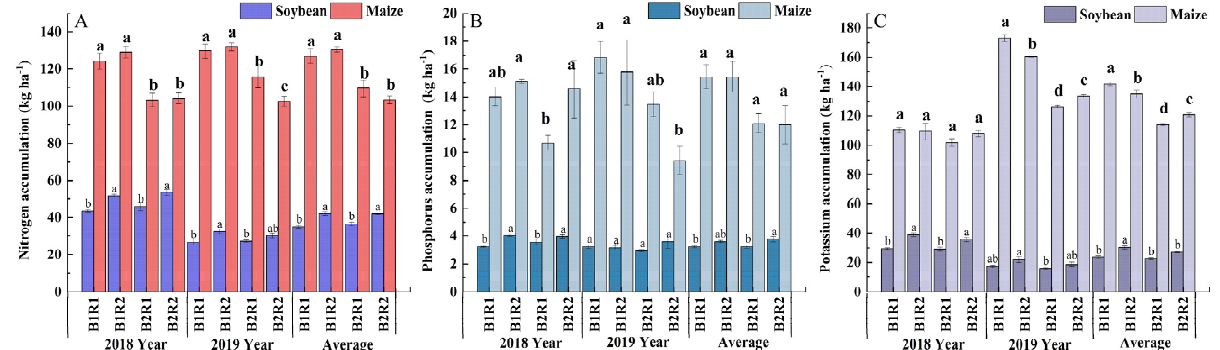
Figure 3. Nutrient accumulation of maize and soybean in sole and intercropping systems in the 2 yr. ( A – C ) represent the N, P, and K accumulation among different intercropping treatments, respectively. Different lowercase letters above the bars indicate significant differences ( p < 0.05). Values are means ± standard error.